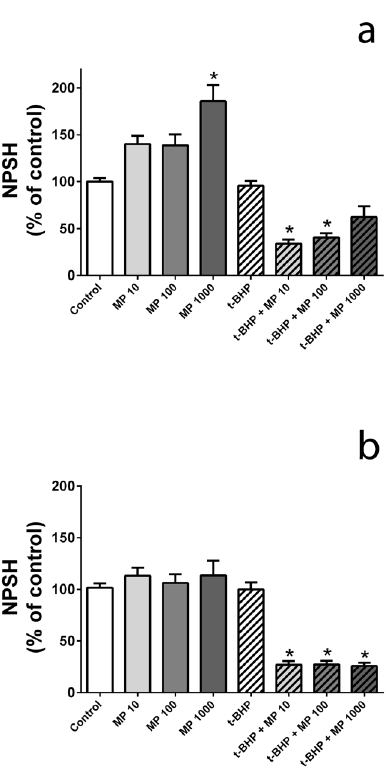
Figure 1 – Effect of M. pulegium AE ( a ) and EE ( b ) on basal and/or t-BHP-induced NPSH oxidation in erythrocytes. * indicates statistical difference (P<0.05) from respective control ( i.e . from basal or from t-BHP); n=5; MP = Mentha pulegium.